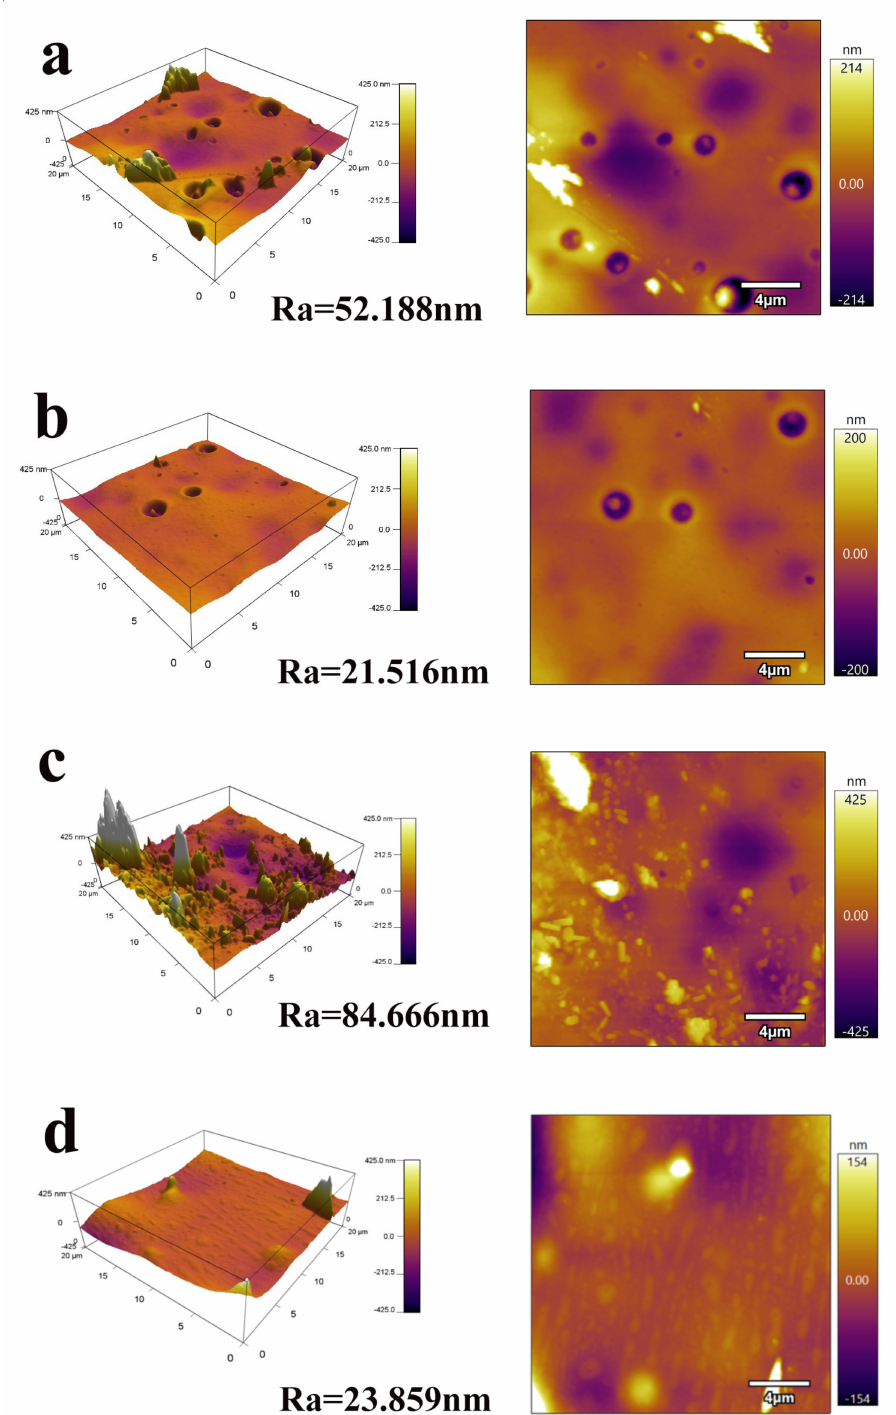
Figure 3. AFM images of different mass ratios of PVA-HC/TP under different ultrasonic durations: ( a ) TP1-0, ( b ) TP1-45, ( c ) TP10-0, ( d )